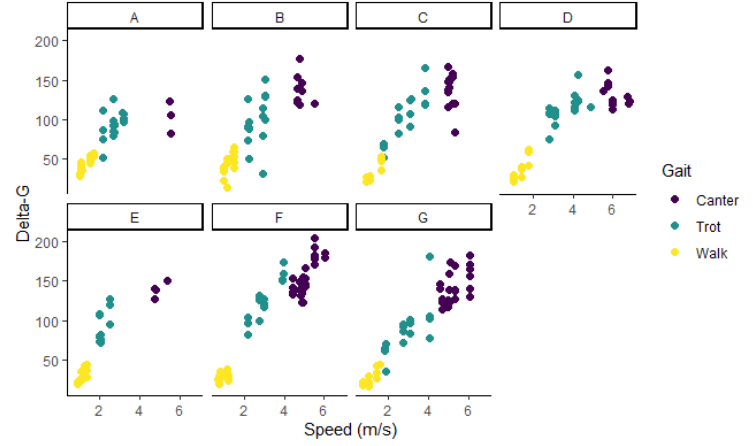
Figure 5. Scatterplot of speed and delta-G, and the distribution of gait for seven Huntaway dogs (A to G) on a treadmill.